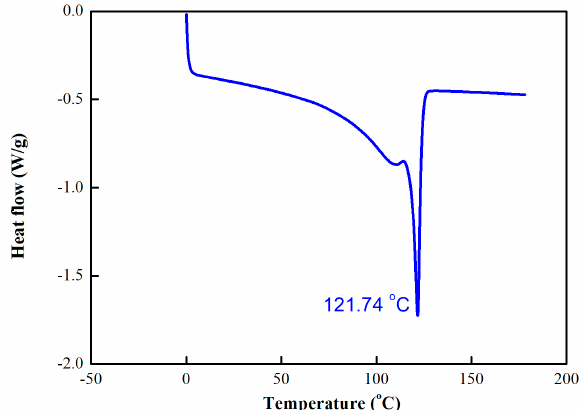
Figure 2. Differential scanning calorimetry (DSC) curve of the selected PE film.